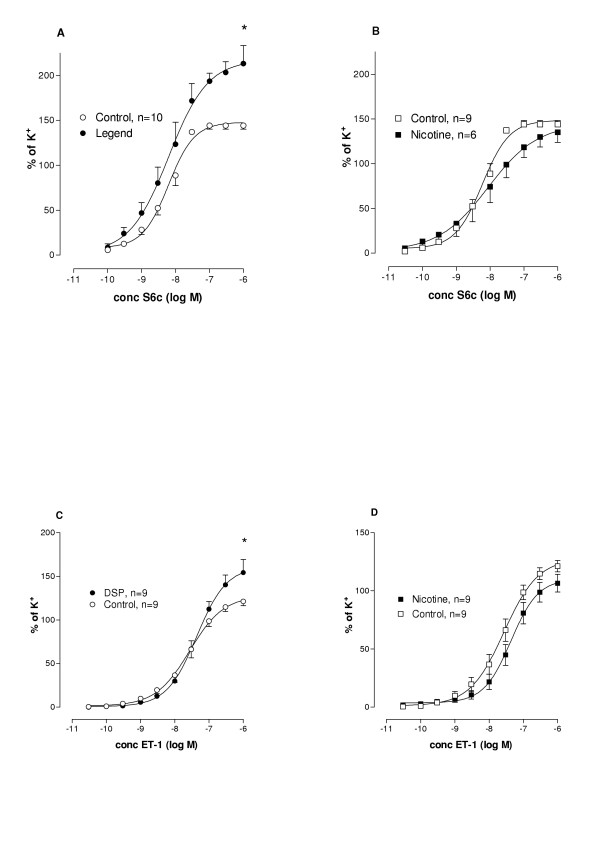
ET-1 and S6c contraction after 24 H of DSP or nicotine incubation. Bronchial smooth muscle cell responses to the concentration-dependent application of sarafotoxin 6c (S6c) or endothelin-1 (ET-1) following incubation for 24 h together with DSP (A, C) or nicotine (B,D) as compared with incubation control (DMEM). Mean values with S.E.M. are given. Unpaired t-tests were used to compare the groups in terms of maximum induced contraction; * P < 0.05.